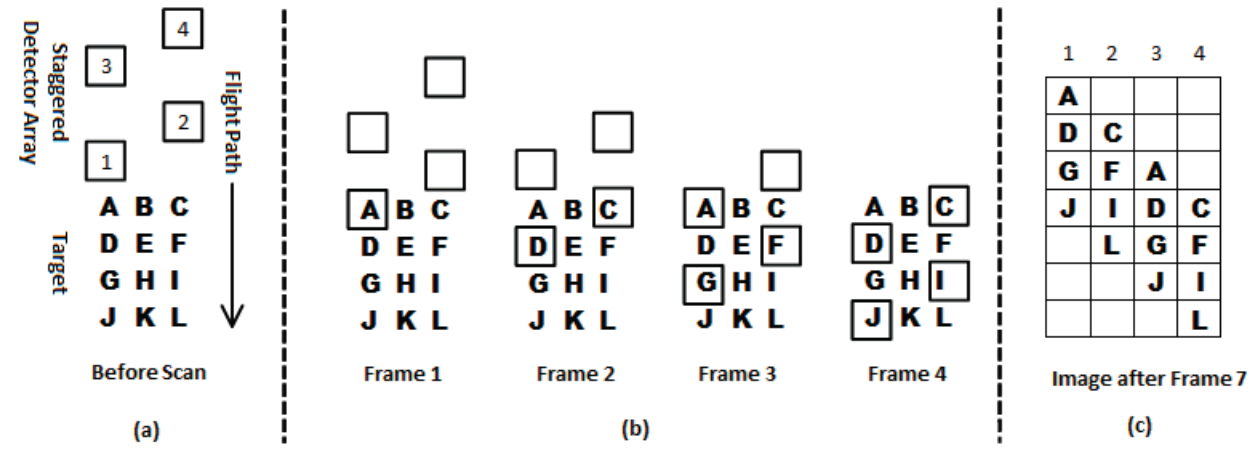
Figure 2. ( a ) Setup of a yawed, staggered detector array about to scan a target; ( b ) execution of the side-slither maneuver over the target; ( c ) image of the